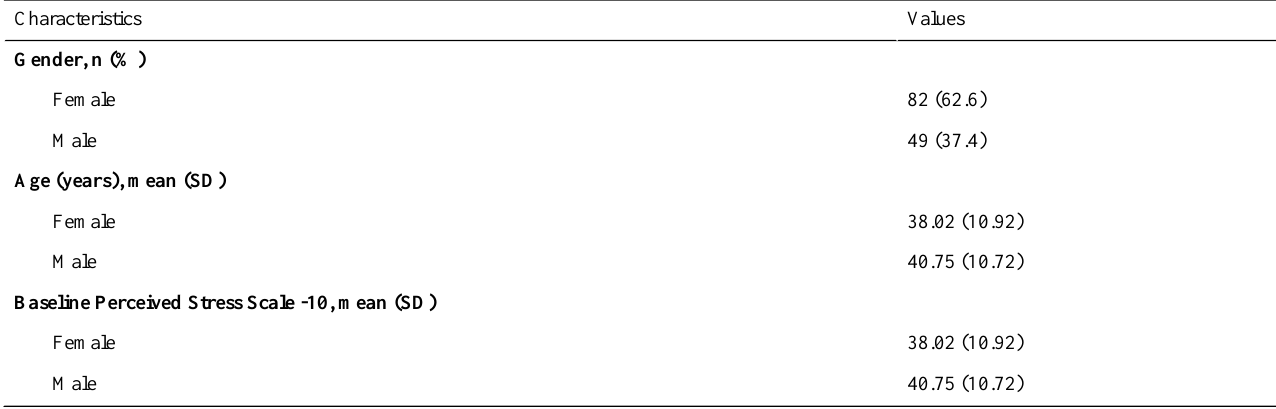
Table 1. Demographic characteristics of treatment cohort (N=131).